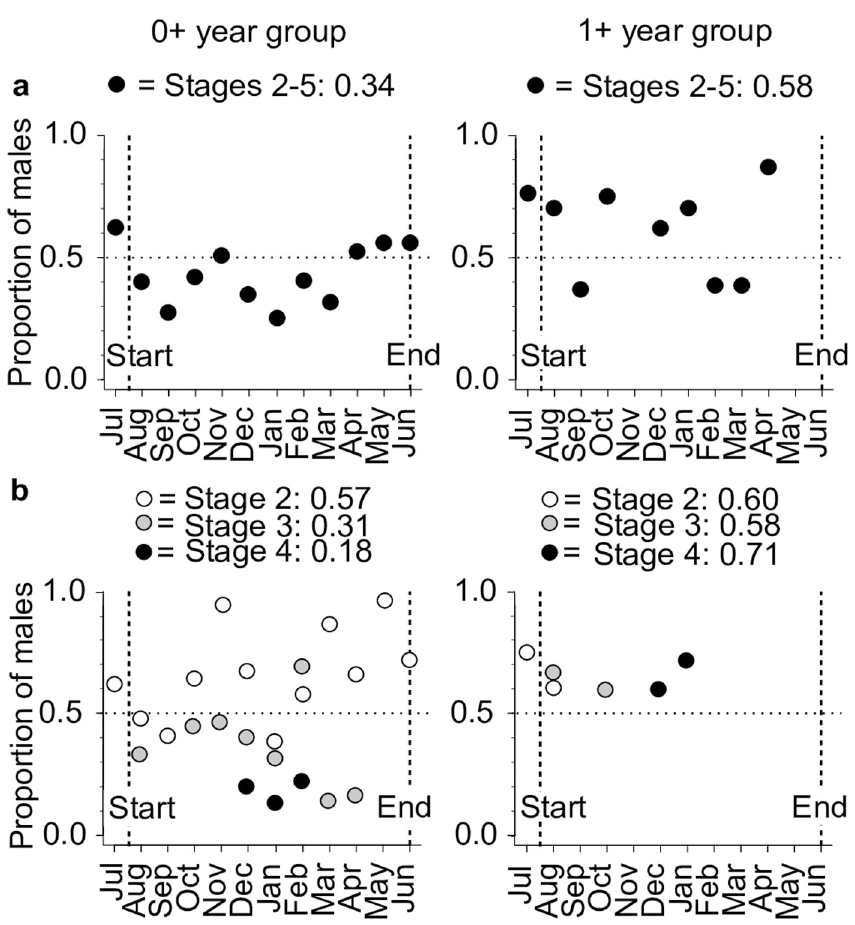
Fig 11. Variation in sex ratio for the 0+ and 1+ year groups of Brachyhypopomus beebei . a. Sex ratio for all sexed individuals (gonad Stages 2–5). b. Sex ratio of individuals at successive gonad stages (2 through 4). For a. and b. results for a given month are provided only where n individuals per category � 10. Ratios reported at the top of each plot refer to all 12 months of the study